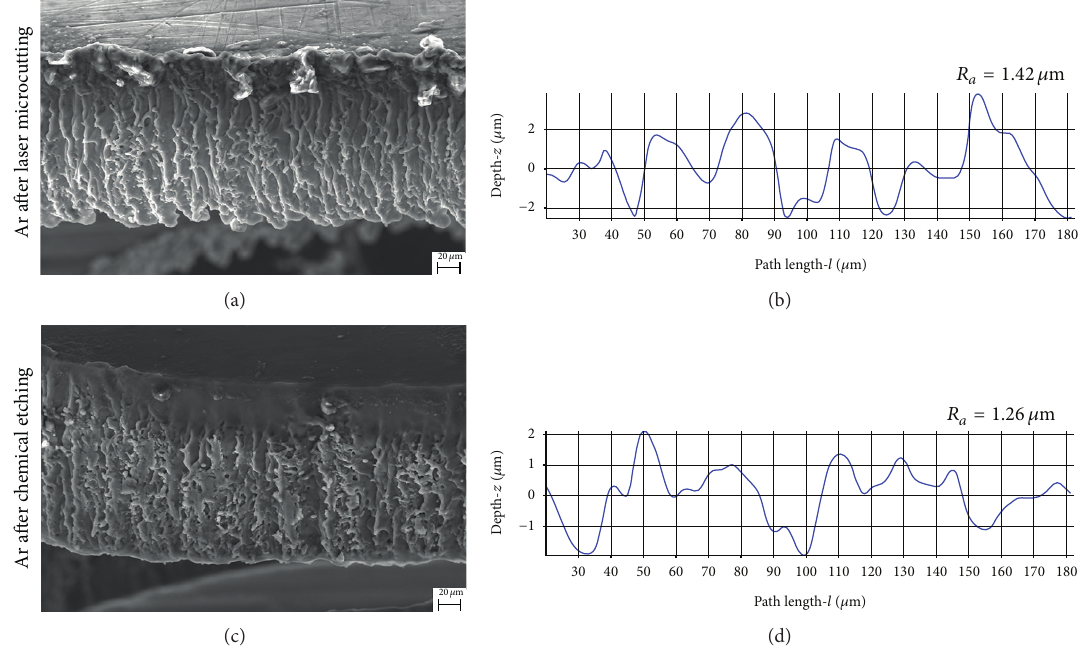
Figure 10: SEM images and roughness profiles of the stent after laser microcutting and chemical